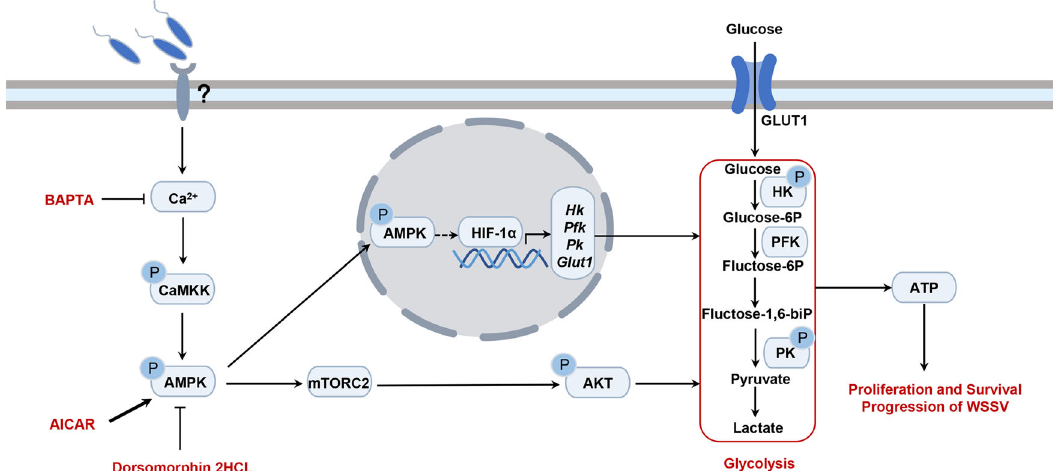
Fig. 10 Schematic representation of AMPK activating mTORC2 signaling to promote viral proliferation. WSSV activates AMPK through the Ca 2 + - CAMKK signaling pathway, and AMPK promotes mTORC2-AKT signaling to positively modulate the glycolysis pathway to provide energy for replication of WSSV in the host. In addition, AMPK can enter the nucleus to activate transcription factors and positively regulate glycolysis-related